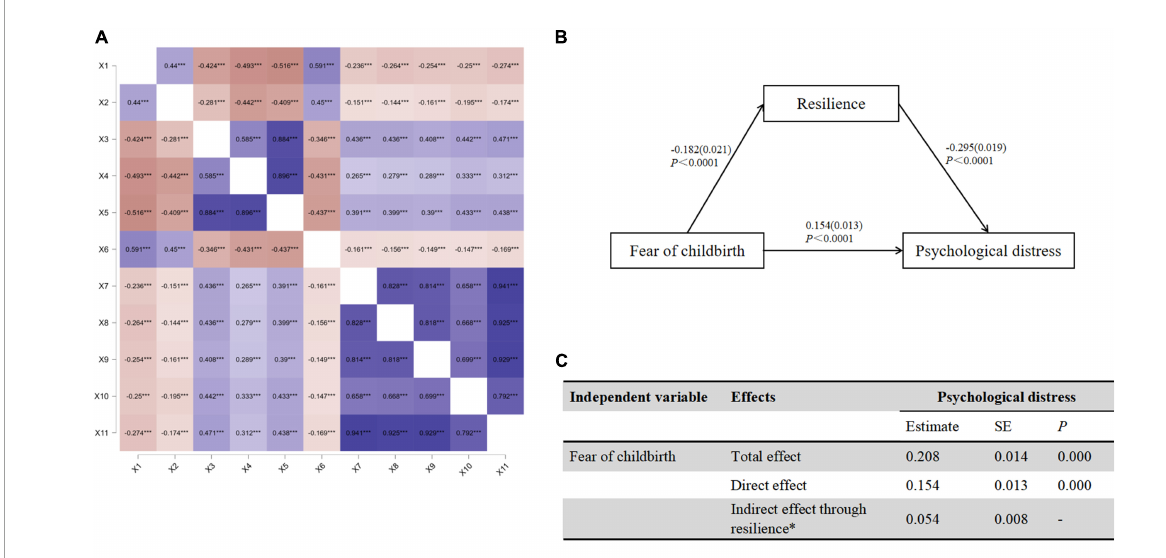
FIGURE2 (A) Correlations between variables. (B) The mediating effect of resilience on psychological distress. (C) Direct and indirect (mediation) effect of resilience on psychological distress. X 1 : resilience, X 2 : perceived social support, X 3 : anxiety, X 4 : depression, X 5 : psychological distress, X 6 : self-efficacy, X 7 : baby-related FOC, X 8 : general and personal control-related FOC, X 9 : pain and injury-related FOC, X 10 : medical interventions and hospital care-related FOC, X 11 : Fear of childbirth. ***Correlation is significant at the 0.001 level.